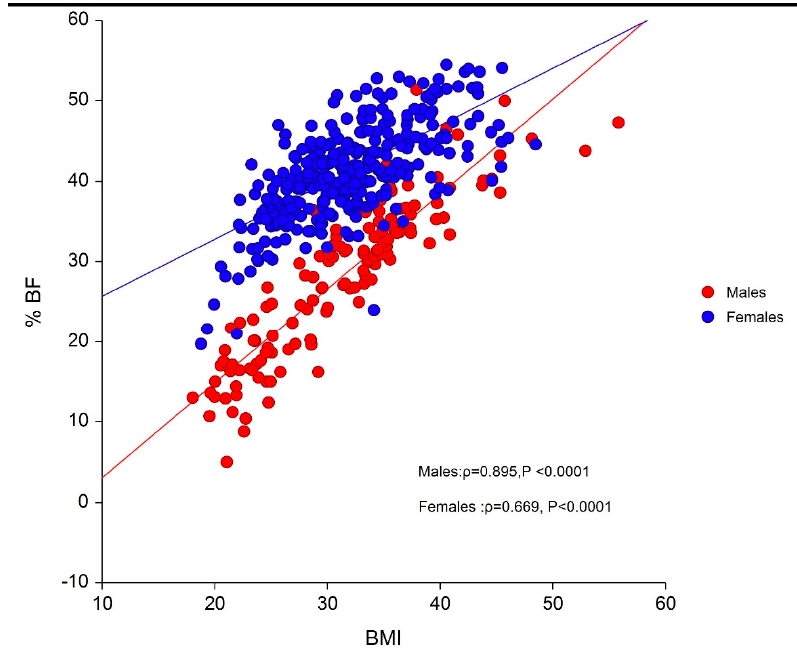
Figure 1. Association between BMI and BF% of the study sample (n = 442).